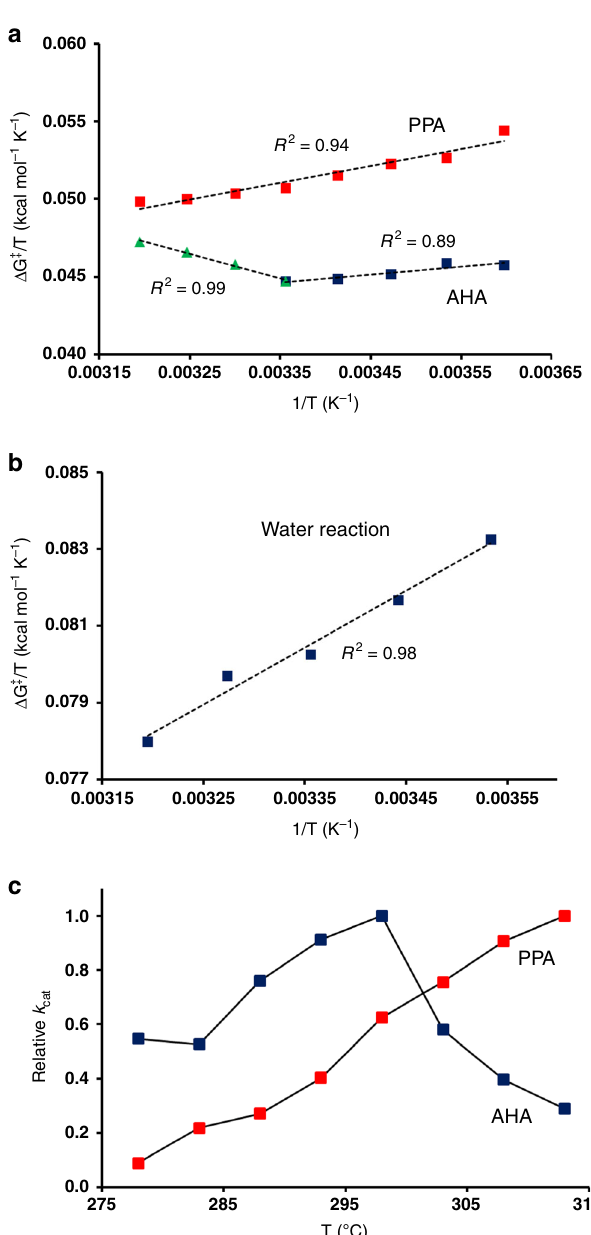
Fig. 3 Temperature dependence of the glycosylation reaction. Arrhenius plots of Δ G ‡ / T vs. 1/ T for the catalyzed reactions in ( a ) AHA and PPA and ( b ) for the reference reaction in water. Linear regression fi ts from which thermodynamic parameters are calculated are denoted by dashed lines. c Calculated temperature dependence of the relative rate constants k cat for AHA (blue) and PPA (red). The s.e.m. for the calculated free energy barriers is 0.08 – 0.14 kcal mol − 1 (from ~300 replicate simulations).